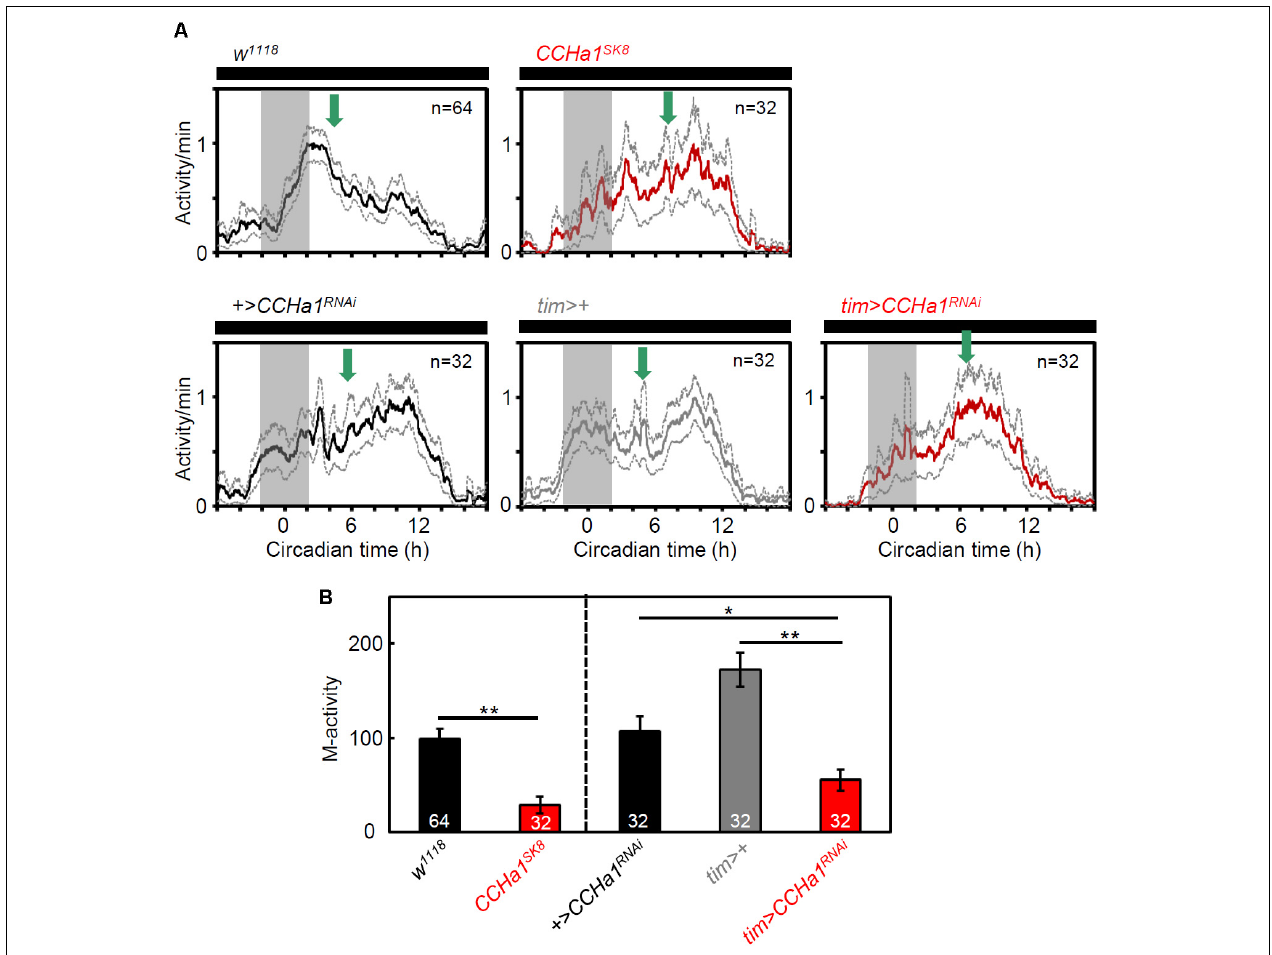
FIGURE 6 | Morning activity of CCHa1 mutants and CCHa1 knockdown flies on the 1st day in DD. (A) Average activity profiles ( ± SEM) of w 1118 control flies, CCHa1 SK8 mutants, UAS control flies ( UAS-dicer2;+/UAS-CCHa1 RNAi = + > CCHa1 RNAi ), tim-Gal4 control flies ( UAS-dicer2;tim-Gal4/+ = tim > + ), and CCHa1 knockdown flies ( UAS-dicer2;tim-Gal4/UAS-CCHa1 RNAi = tim > CCHa1 RNAi ). All activity profiles were normalized to 1. Green arrows point to the mean acrophase in the different strains calculated by ActogramJ. Compared with w 1118 , + > CCHa1 RNAi , and tim > + flies, the acrophases of CCHa1 mutants and CCHa1 knockdown flies were phase-delayed. (B) Activity (mean ± SEM) of CCHa1 mutants and CCHa1 knockdown flies in the morning phase (gray area shown in A ). Kruskal–Wallis test followed by Bonferroni correction; ∗ p < 0.05, ∗∗ p < 0.01.